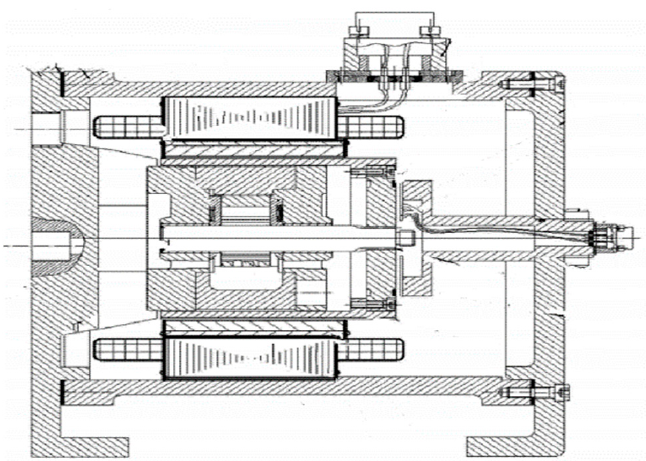
Figure 4. The integrated electric hydraulic pump designed by Beihang University.